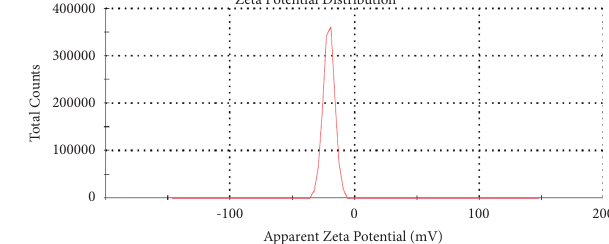
Figure 5: FTIR spectra.